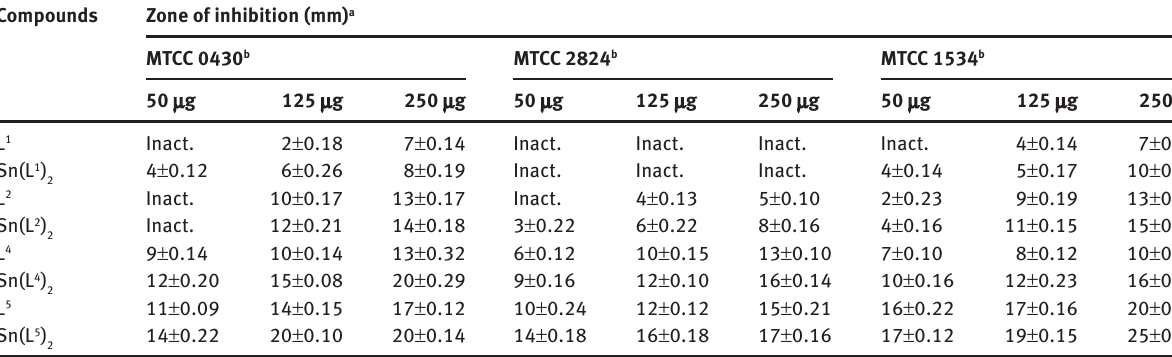
Table 8: Antibacterial activity of ligands and their tin(II) complexes.